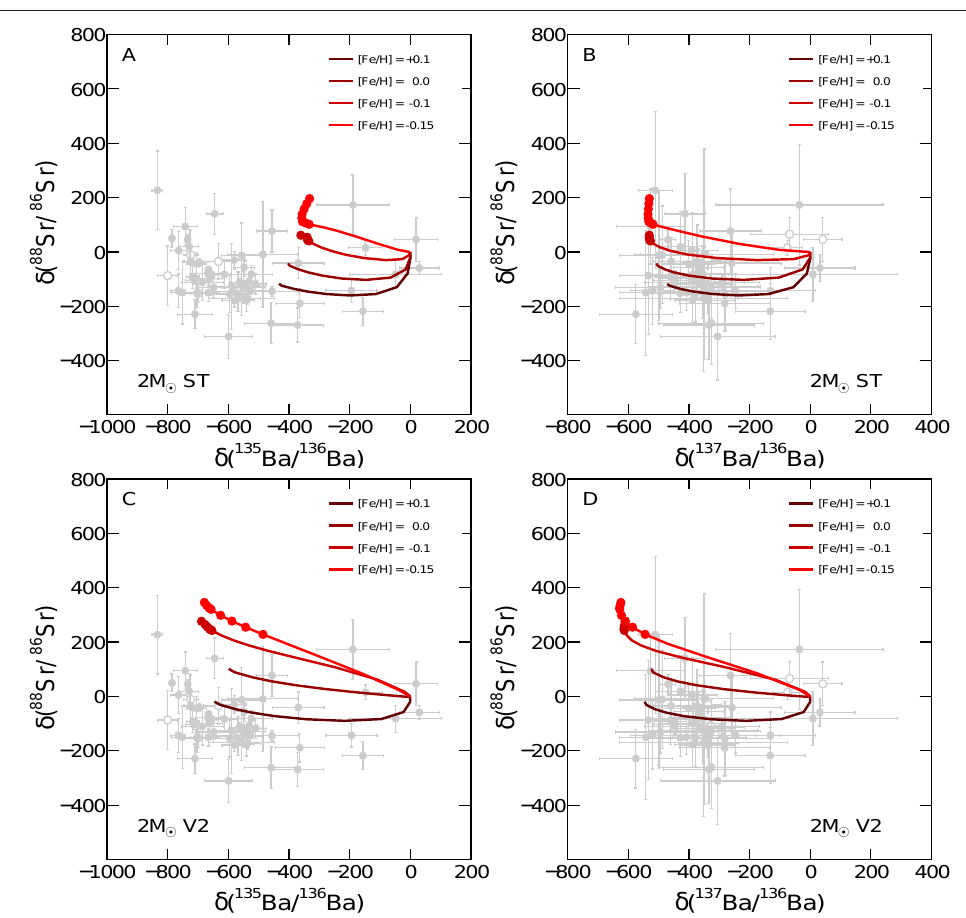
Figure 1. Predictions from 2 M (cid:12) AGB models of di ff erent metallicities (red curves) with SiC grains data (from [19], gray dots with error bars). The case of the isotopic ratios 88 Sr / 86 Sr versus 135 Ba / 136 Ba (panels A and C) and 137 Ba / 136 Ba (panels B and D) are shown. Panels A and B show the envelope composition resulting form calculations run by employing nuclear physics input from set ST, while panels C and D show the output of the same models run with input from set V2 (see the text for details). The full red dots represent model abundance ratios after third dredge-up episodes once the envelope has reached a carbon rich composition [see